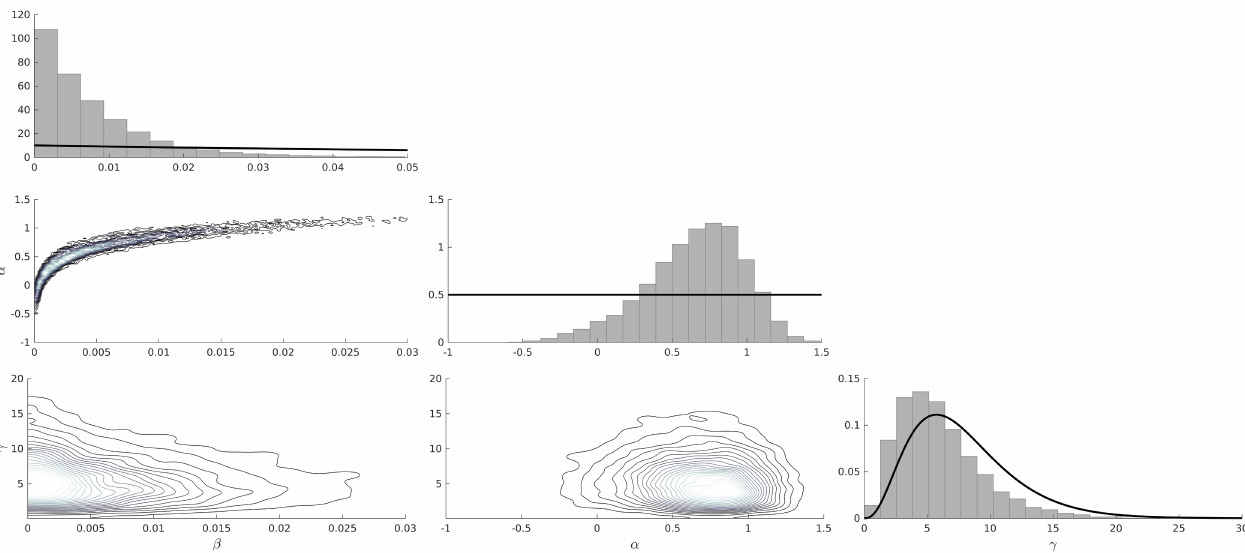
Fig 2. Posterior densities. The histograms (along the main diagonal from top to bottom) show the marginal posterior distributions of β , α and γ respectively with the black solid lines showing the prior densities while the contour plots show the joint posteriors with the lighter shading indicating the most likely region of the parameter